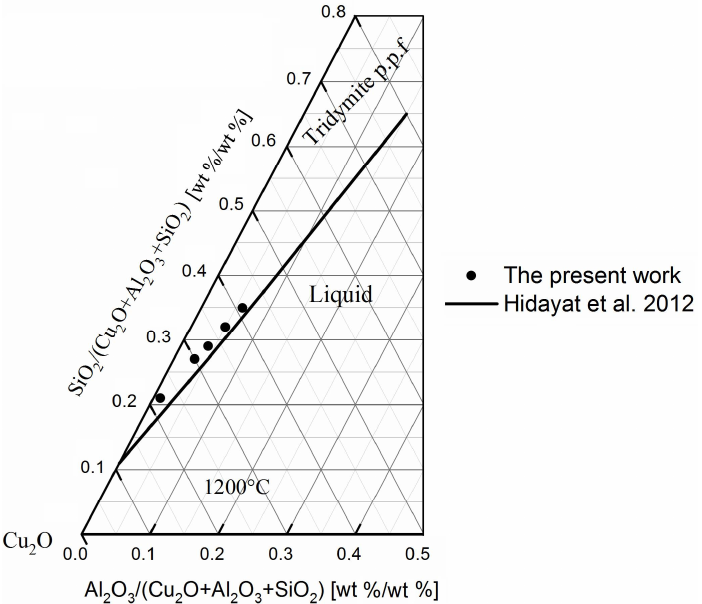
Figure 6. Liquidus lines of the Cu 2 O–Al 2 O 3 –SiO 2 system in equilibrium with tridymite and metallic copper.